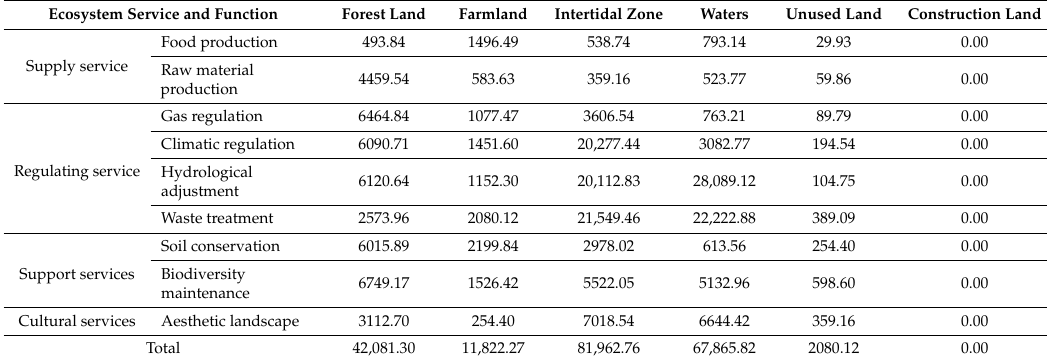
Table 2. Value coefficients (RMB/ha/year) of ecosystems